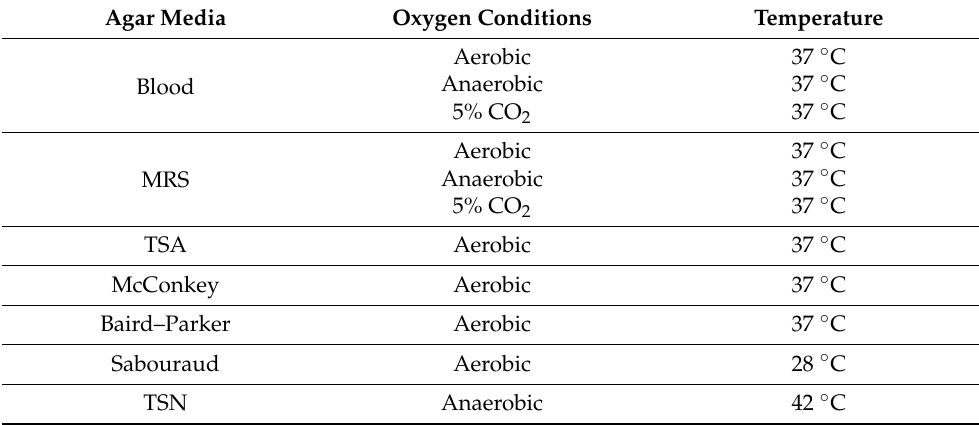
Table 1. Oxygen and temperature conditions for the different culture